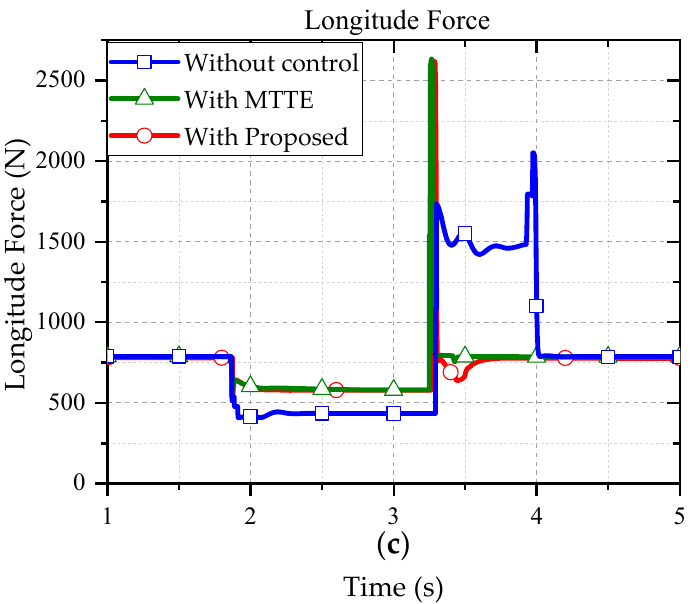
Figure 7. Comparison of the vehicle’s front left wheel without control, with MTTE and with proposed approach: ( a ) wheel speed and chassis speed; ( b ) slip ratio; ( c ) longitudinal force.